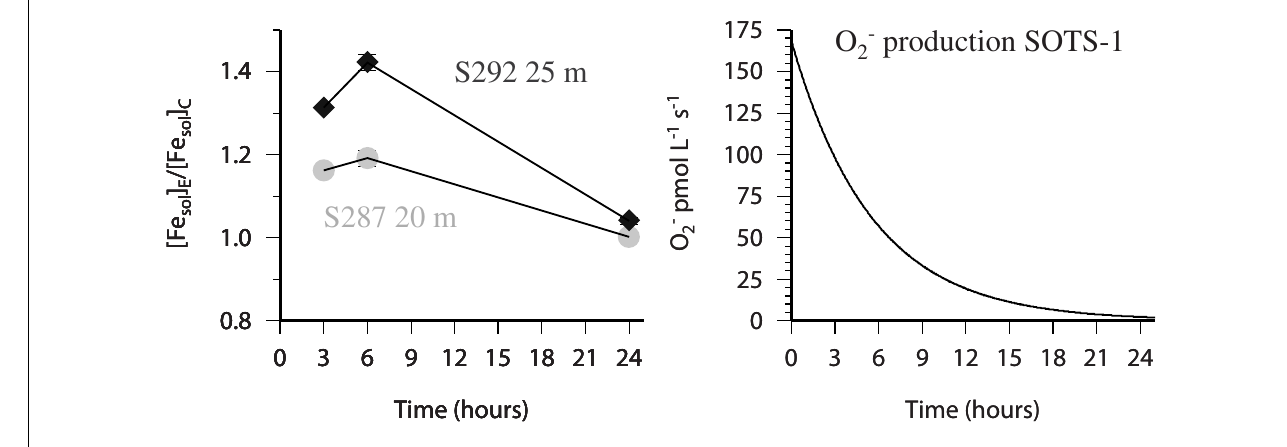
in both the presence (experimental-E) and absence (control-C) of the thermal O − source SOTS-1. (Right)Time course of the production flux of O − 2 from the thermal decay of SOTS-1 in the experimental treatment (see text for more